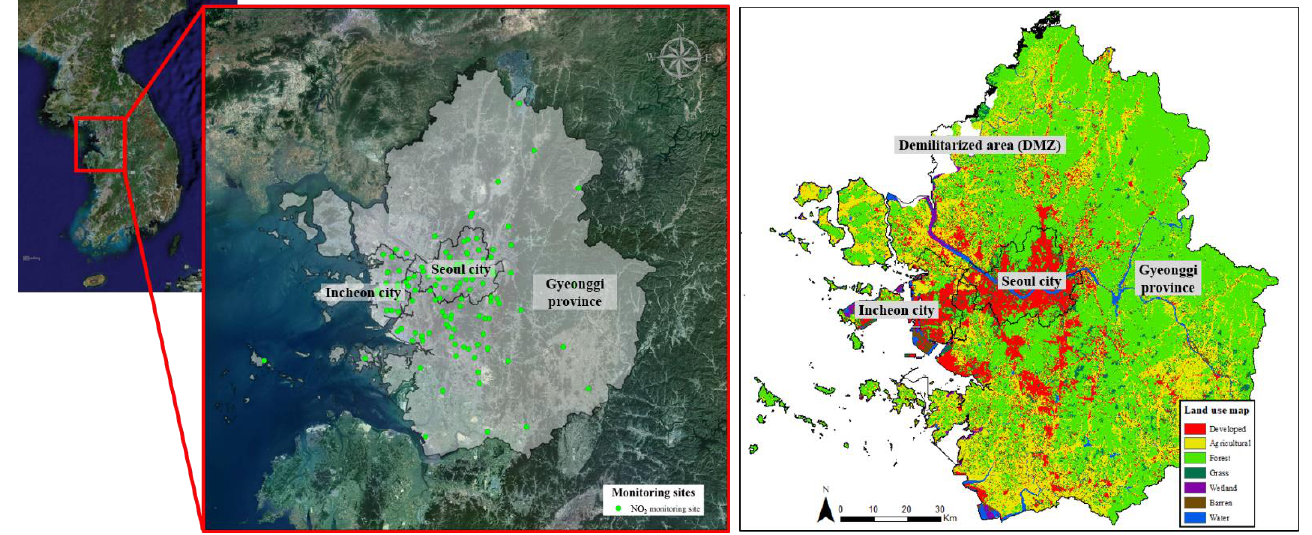
Figure 1. Study area. Location of the Capital metropolitan area (Seoul city, Incheon city, Gyeonggi province) with the 125 NO 2 monitoring sites collected for 2018 (Airkorea), and Land use map for the study area.